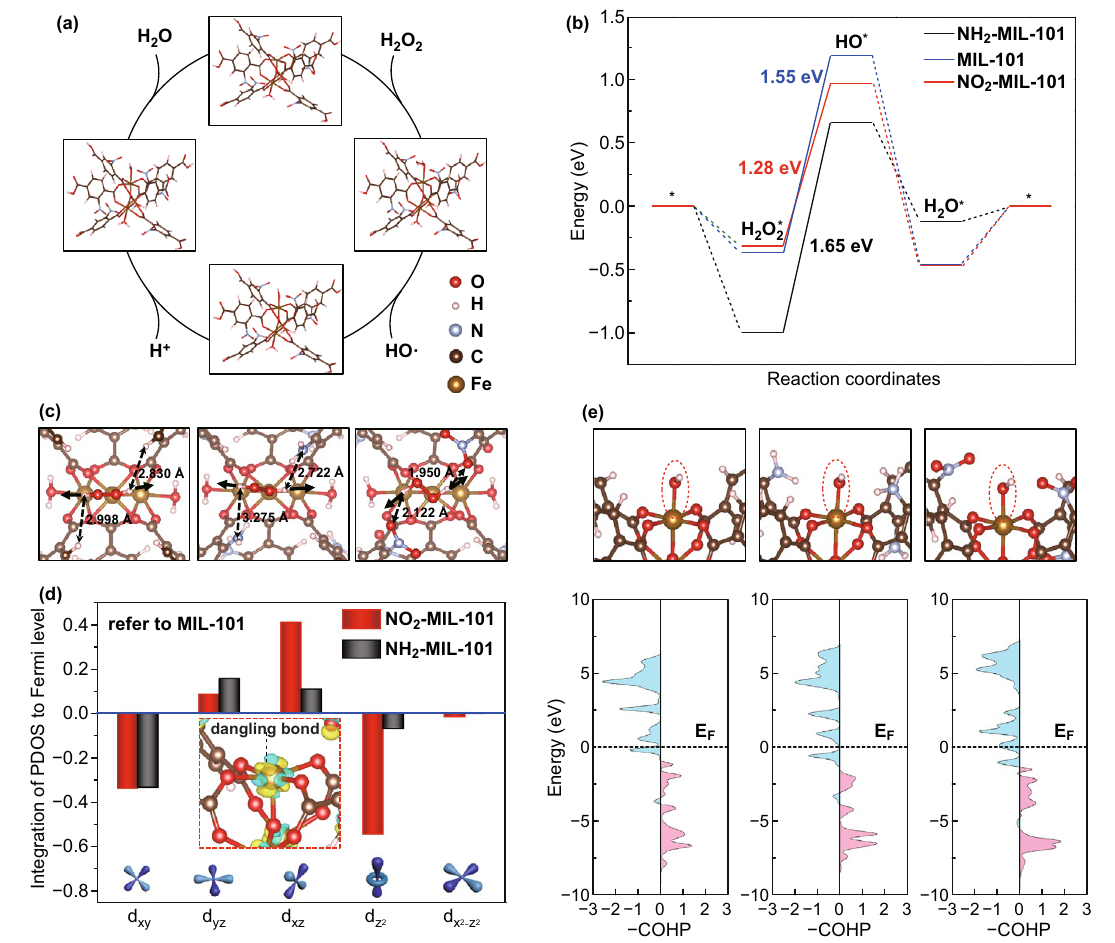
Fig. 3 a Schematic diagram of the elementary step of reaction in an acidic environment on NO 2 -MIL-101. b Energy change diagram of reac- tion on MIL-101, NH 2 -MIL-101 and NO 2 -MIL-101, respectively. c Geometry structure of H 2 O 2 * adsorbed on MIL-101, NH 2 -MIL-101 and NO 2 -MIL-101 (from left to right). The solid arrows represent the orientation of the O–H bond, and the dotted line represents the distance from H on the adsorbed H 2 O 2 to the ligand. d Integration of the PDOS to Fermi level of each split Fe 3d orbit on MIL-101, NH 2 -MIL-101 and NO 2 -MIL-101, where the unmodified MIL-101 is taken as a reference. Inset: the local view near the Fe active site, yellow (blue) isosurfaces denote an increase (decrease) of 0.01 e/Å-3 for electronic density. e Schematic diagram of HO*-Fe bond and the corresponding pCOHP (from left to right: MIL-101, NH 2 -MIL-101 and NO 2 -MIL-101,